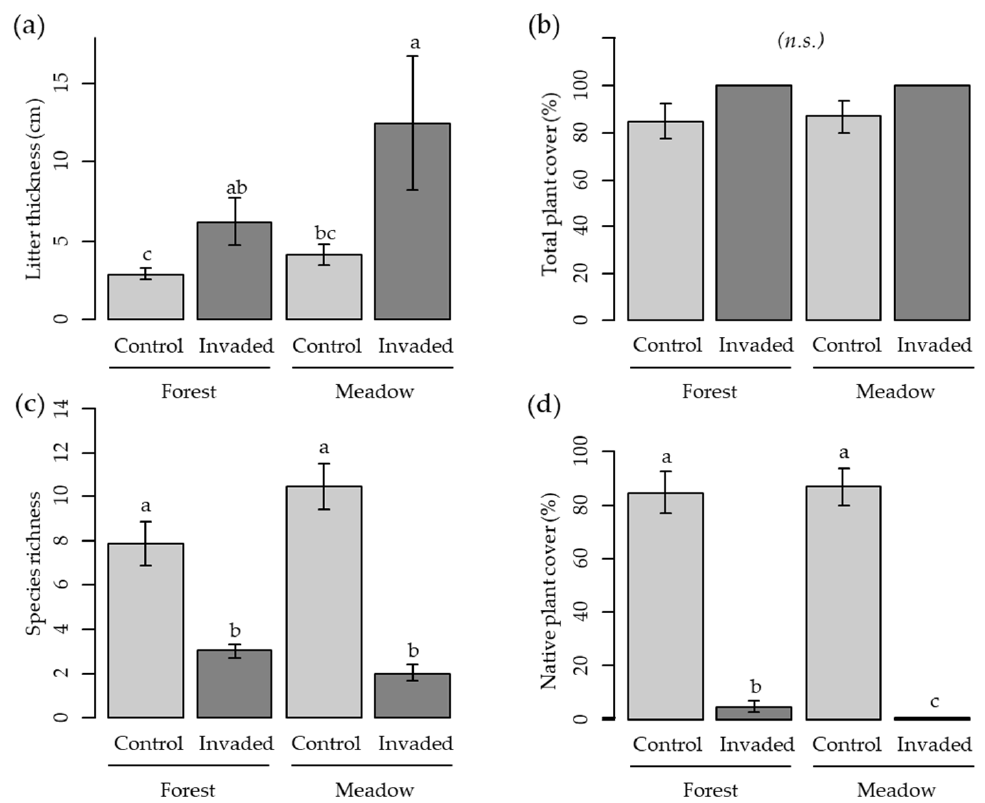
Figure 1. Effects of habitat (forest and meadow) and knotweed on ( a ) litter thickness and plant community parameters: ( b ) total plant cover; ( c ) plant species richness; ( d ) native plant cover. Values are means ± standard errors. Significant differences according to Tukey post hoc tests are indicated by different letters. n.s.: not